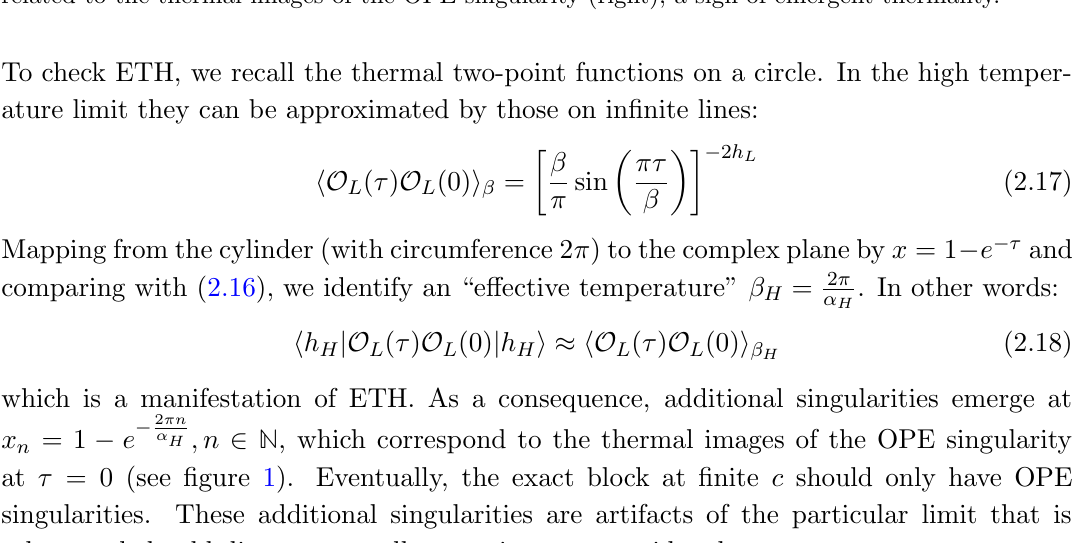
Figure 1 . Forbidden singularites in the leading order results (left), via a conformal mapping, are related to the thermal images of the OPE singularity (right), a sign of emergent